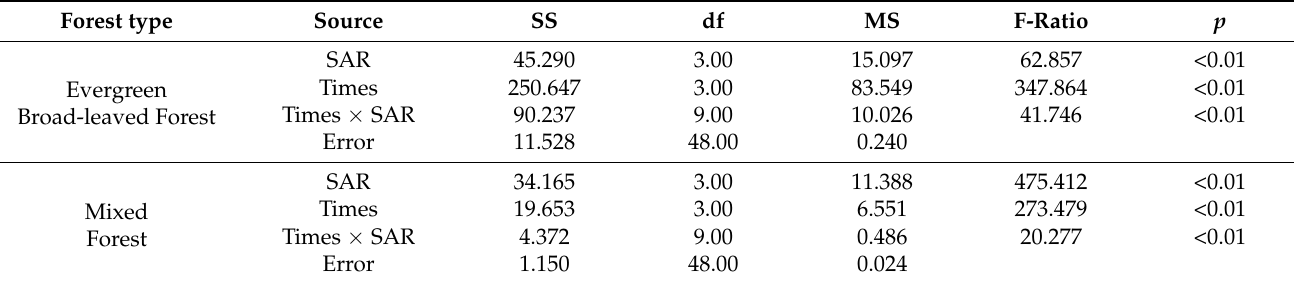
Table 6. ANOVA of soil cellulase activity.